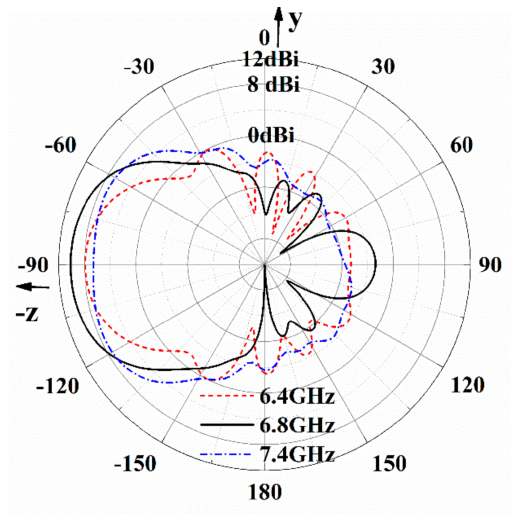
Figure 6. Radiation patterns of the antenna.